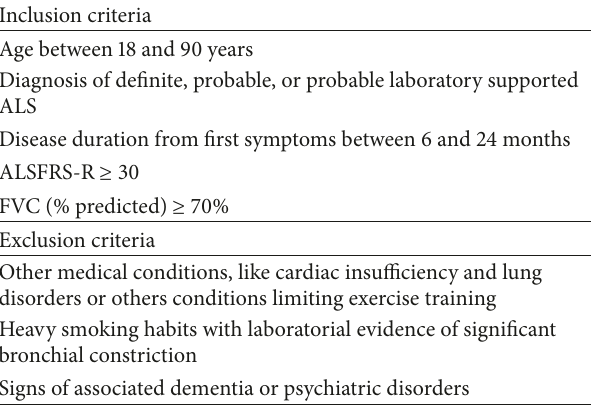
Table 1: Inclusion and exclusion criteria of the present